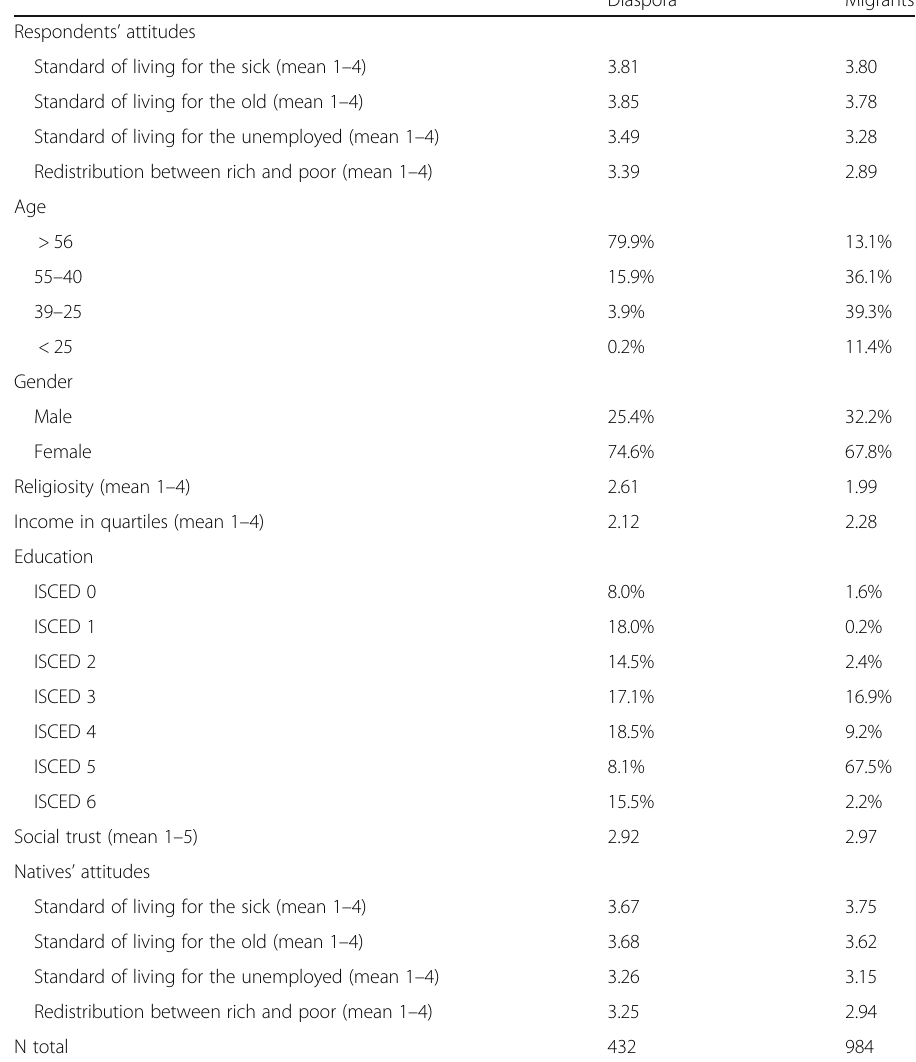
Table 3 Descriptive statistics on the variables used for